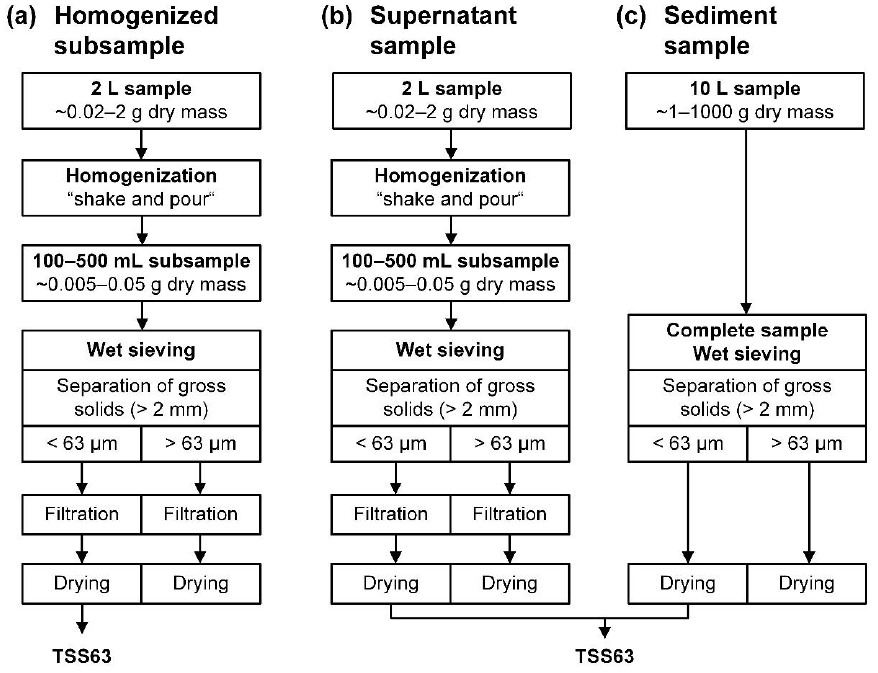
Figure 4. Analytical steps for measuring the concentration of total suspended solids < 63 µm (TSS63).